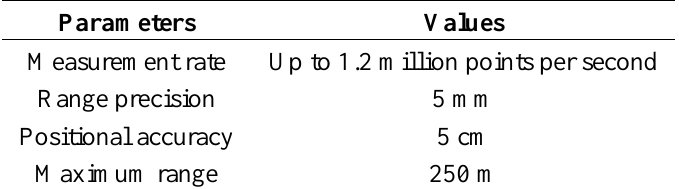
Figure 12. An Optech Lynx mobile mapping system [33]. Table 1. Specifications of Optech Lynx, the mobile mapper used to collect data in this